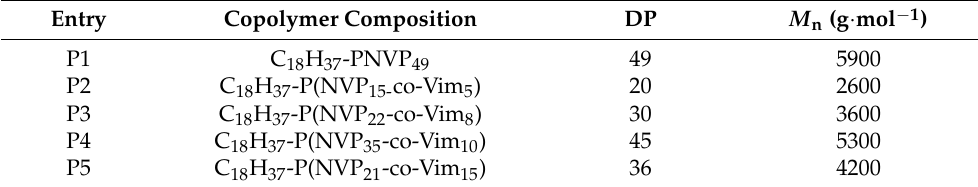
Characterization of NVP and Vim-based copolymers determined by 1 H NMR in N , N -dimethylformamide (DMF) at 80 ◦ C (DP: degree of polymerization; Mn: number average molecular